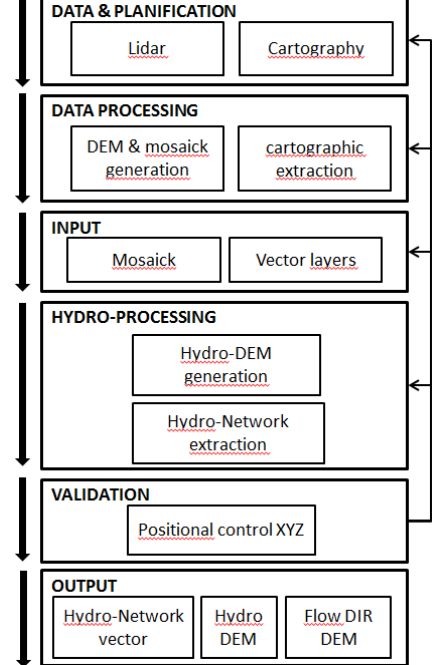
Figure 2. Flux diagram of the metodology for automatic river